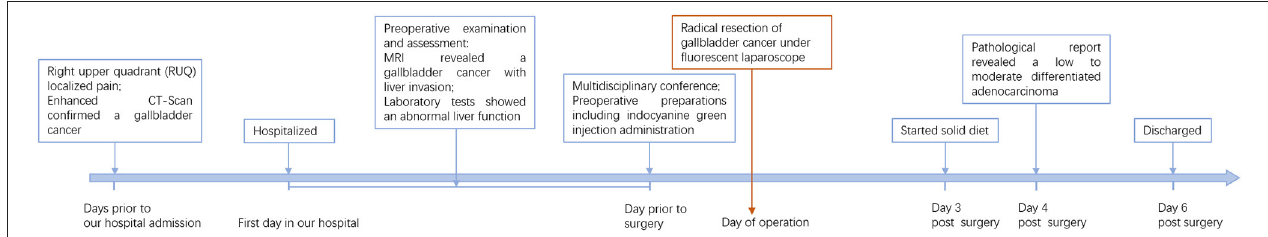
FIGURE 4 | The timeline of patient